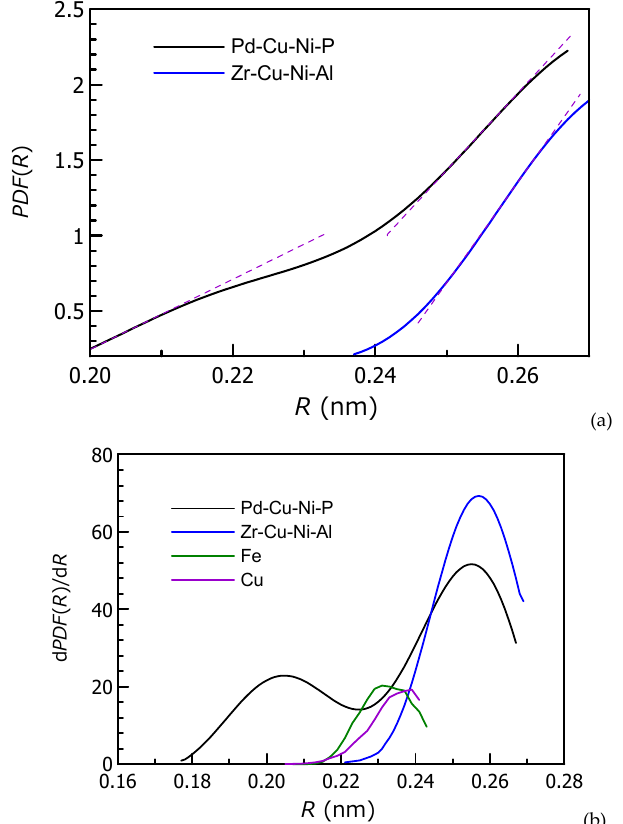
Figure 10. ( a ) PDF ( R ) of the Pd 42.5 Cu 30 Ni 7.5 P 20 and Zr 55 Cu 30 Ni 5 Al 10 bulk metallic glasses at room temperature. The data were used from Refs. [136,152]. ( b ) d PDF ( R )/d R of the Pd 42.5 Cu 30 Ni 7.5 P 20 , Zr 55 Cu 30 Ni 5 Al 10 (this time PDF ( R ) = g( R ) is used) BMGs bulk metallic glasses as well as of Fe and Cu (MD simulation shown in Figure 2) as a function of R .